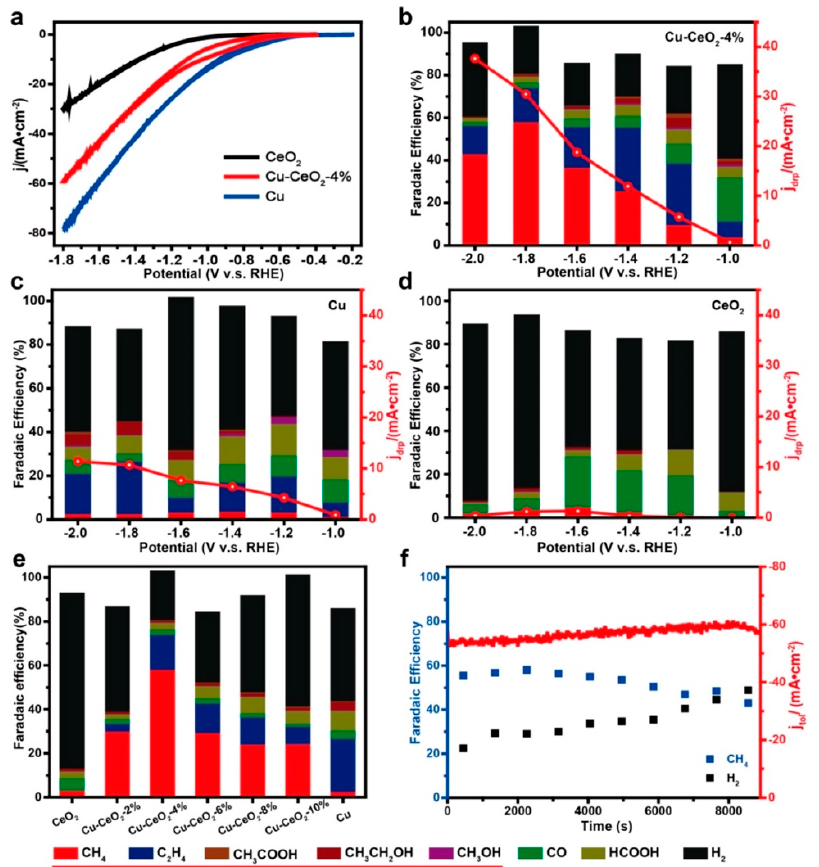
Figure 5. Electrochemical CO 2 reduction performance. ( a ) Cyclic voltammetry curves for Cu-CeO 2 , CeO 2 , and Cu. ( b − d ) Faradaic efficiencies (bars on the left y − axis) and deep reduction product current density ( j drp , red curves on the right y − axis) of ( b ) Cu − CeO 2 − 4%, ( c ) pure Cu, and ( d ) undoped CeO 2 at various overpotentials. The deep reduction products were the first five products in the legends at the bottom, marked with a red line. ( e ) A comparison of the Faradaic efficiency of samples with varying levels of Cu doping. ( f ) Stability of FE CH4 (blue squares) and FE H2 (black squares) on the left y − axis. Right y − axis: total current density ( j total ) of Cu − CeO 2 − 4% at − 1.8 V (red curves, right y − axis). (Reprinted with permission from Ref. [87]. Copyright 2018 American Chemical Society).